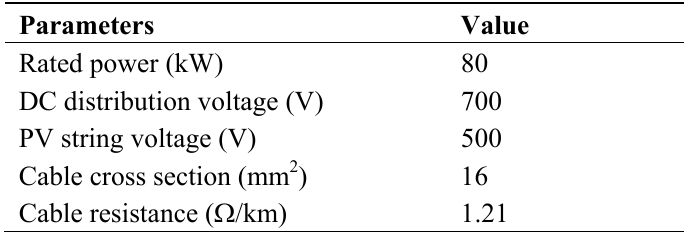
Table 2. Main parameters for the PV system used in the simulation.